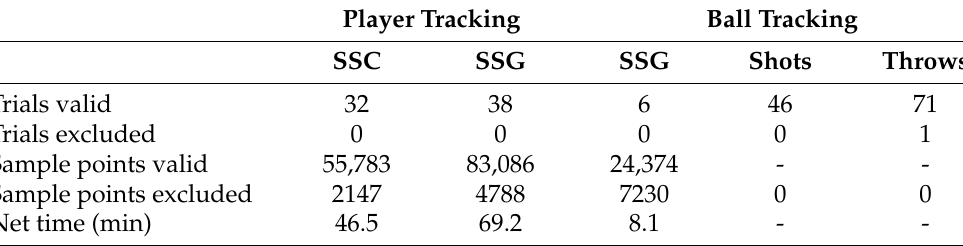
Table 1. Overview of trials and sample points, used for player and ball tracking in SSCs and